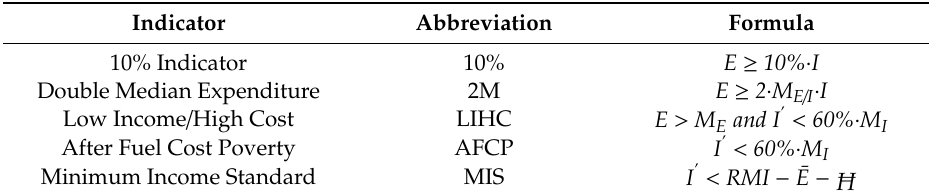
Table 1. Calculation of indicators. 1.